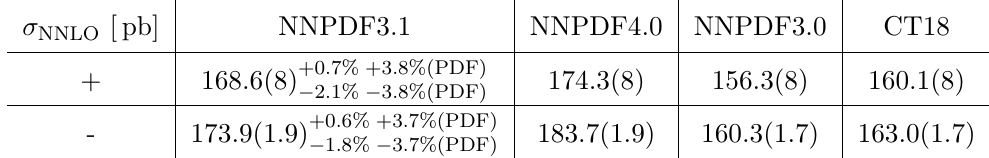
Table 4 . Fiducial cross sections with full off-diagonal CKM dependence at NNLO QCD accuracy √ for both the pp → W + j and pp → W − j process at s = 13 TeV. The predictions are provided c c for four different PDF sets: NNPDF3.1 (default), NNPDF4.0, NNPDF3.0, and CT18. The digit in parenthesis indicates the Monte Carlo statistical error. The scale variation and the PDF variation is provided for the NNPDF3.1 set